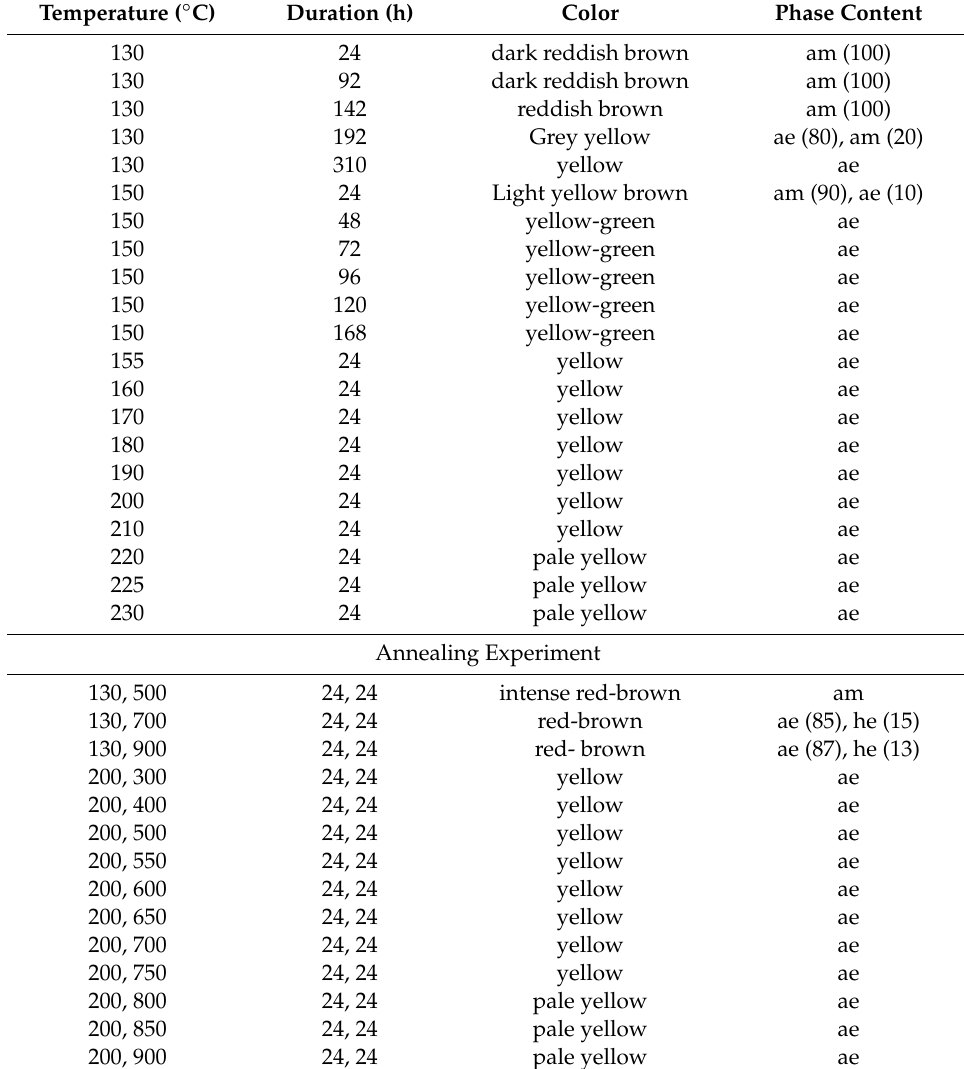
Table A1. Synthesis conditions of hydrothermal and additional heat treatment experiments and experimental